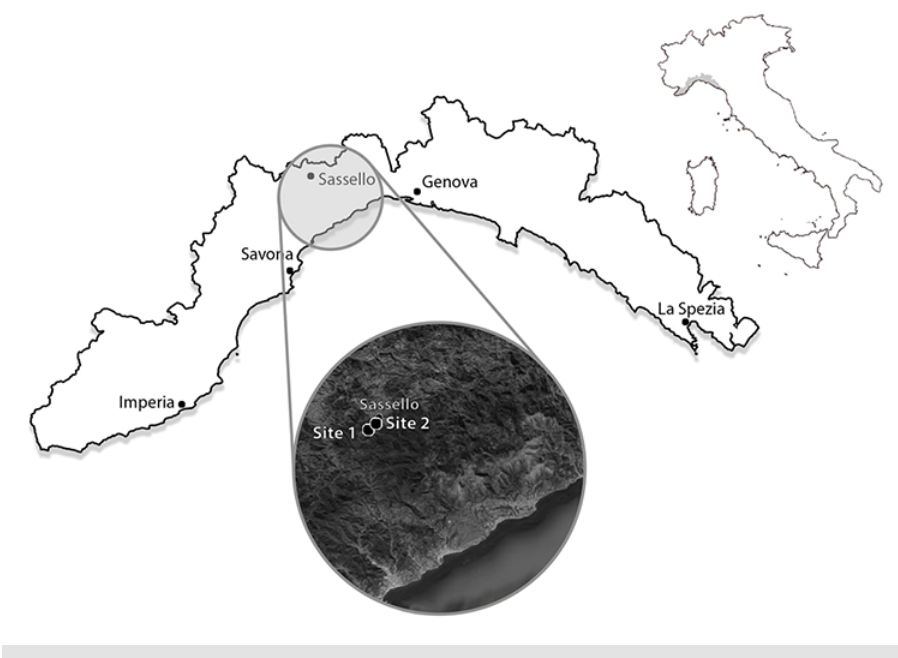
Fig. 1 Geographic location of the study sites.